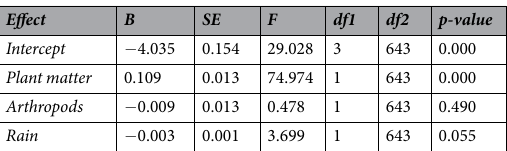
Table 6. Results for the Generalized Linear Mixed Model (GLMM) for model effects on the response tool use count by individual per month and predictor variables food availability and rain precipitation . We used the log of contact time with the individual group as offset